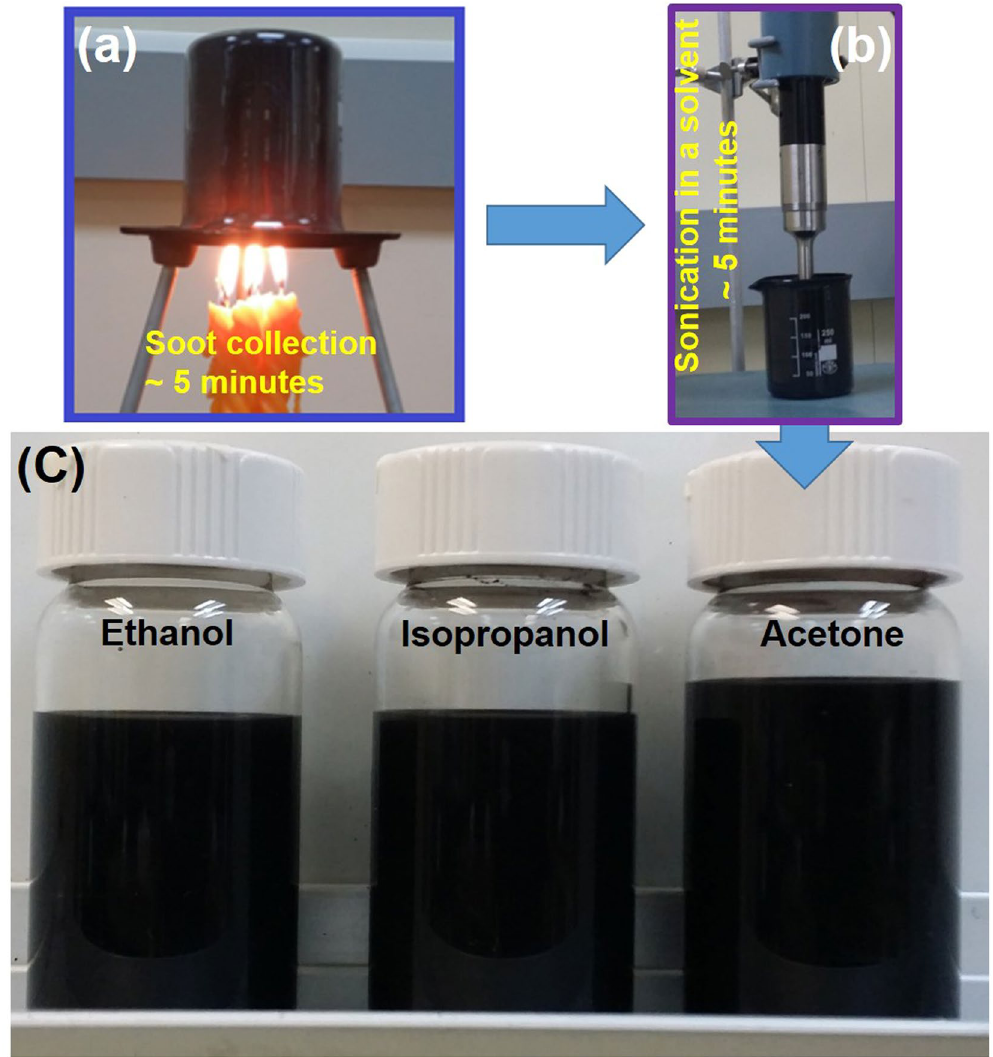
Figure 1. Preparation of candle soot dispersions. ( a ) Candle soot collection: A 250 ml glass beaker is inverted on 5 candle flames such that the zone of incomplete combustion strikes the walls of the beaker for 5 minutes (~250 mg of soot). ( b ) Sonication of collected candle soot in different solvents: The highly stable, homogeneous dispersion of the candle soot in different solvents were prepared by simply mixing the candle soot coated on the beaker with the solvents (250 mg soot dispersed in 250 ml of each solvent), and sonicating it for 5 minutes ( c ) Photograph of prepared candle soot nanoparticles in different solvent as indicated (ethanol, isopropanol and